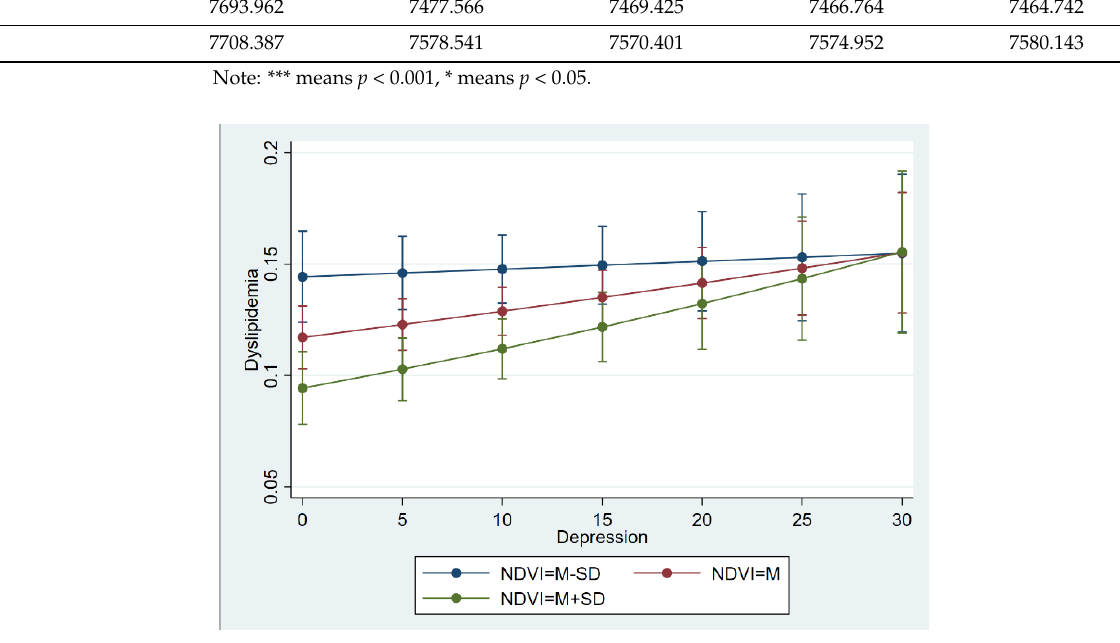
Figure 4. The interaction effect of depression and NDVI on dyslipidemia. Further, multilevel logistic regression was also performed to test the moderate effect of the NDVI on the relationship between depression and dyslipidemia across groups such as age (45 – 59/60+), gender (male/female), and residence (central of city/town, urban – rural integration zone, rural).